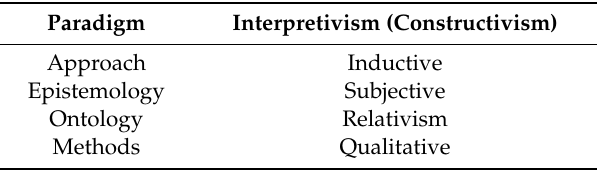
Table 1. Summary of this Research Paradigm.